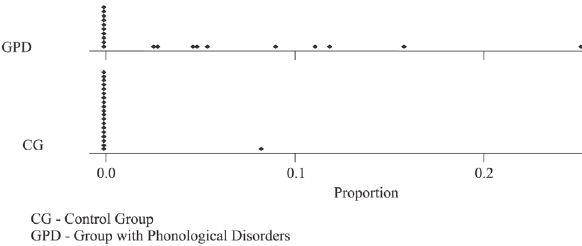
Figure 3 - Points of proportion of distortion occurrences in the SS1 test.